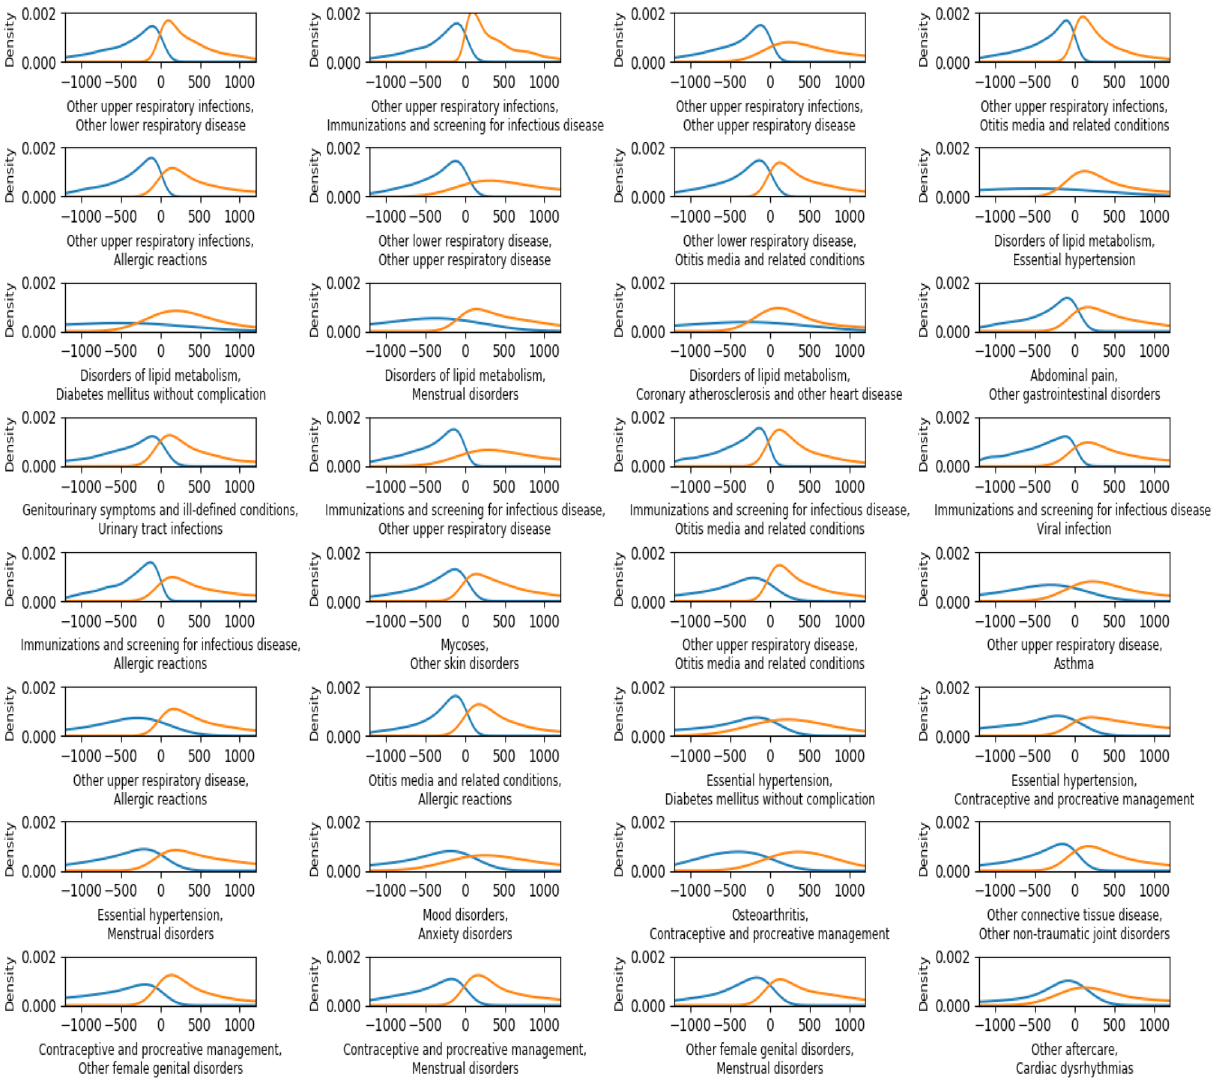
Figure 5. distribution of time delay ( Δt ) for the co-occurrence disease/diagnosis pairs in Fig. 4. The blue curve is about the case of disease 1 occurred earlier than disease 2 and the orange curve is about the case of disease 2 is earlier than disease 1. The figure was generated by using Python 3.6.8 with package of